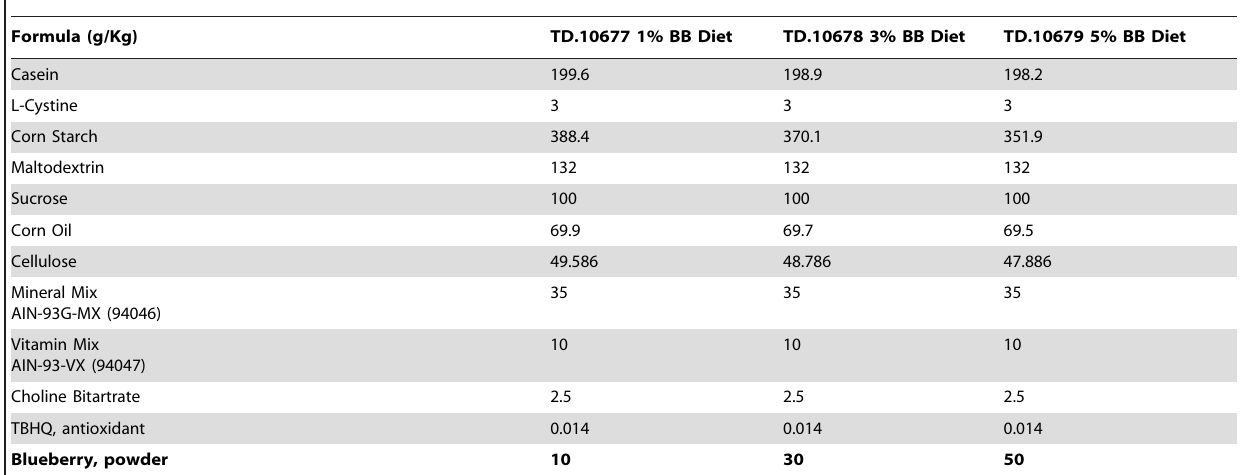
Table 1. Nutrition Composition of Blueberry Diets.